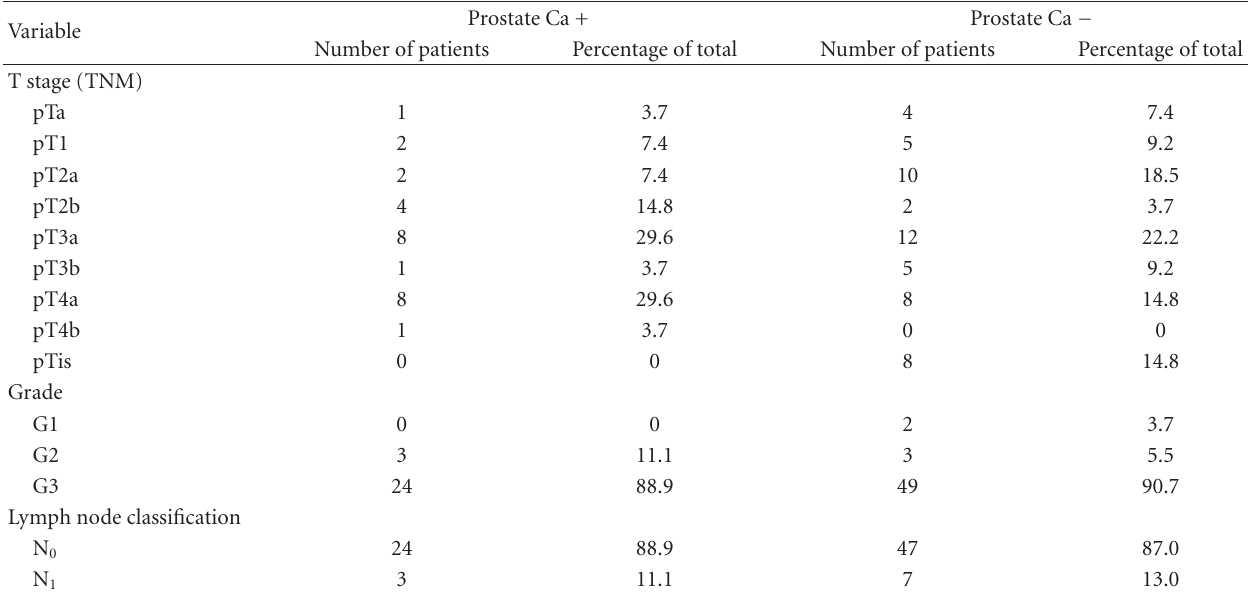
Table 2: The pathological stages of bladder primary